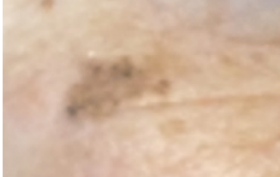
Figure 1: Initially the lesion resembled many other lesions in the patient’s sun-exposed skin areas. The lesion was a 3 mm x 2 mm macule colored tan to dark brown involving the lateral segment of the right inferior eyelid.